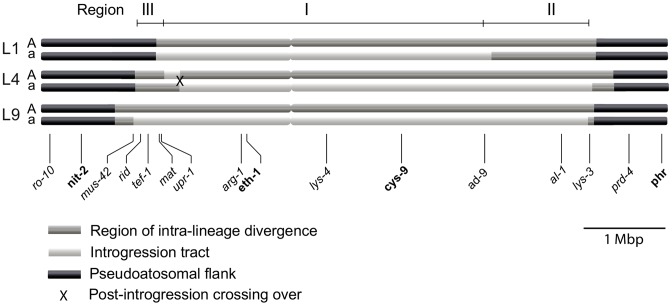
Schematic illustration of the mating-type (mat) chromosomes of the three N. tetrasperma lineages included in the study.Regions of elevated intra-lineage divergence and introgression are defined based on genome divergence estimates. Genes positioned below the chromosomes were used for the phylogenetic and Bayesian concordance analyses. In bold are genes for which representatives of all known heterothallic species and subgroups of Neurospora were included in the phylogenetic analyses. The figure is drawn to scale.